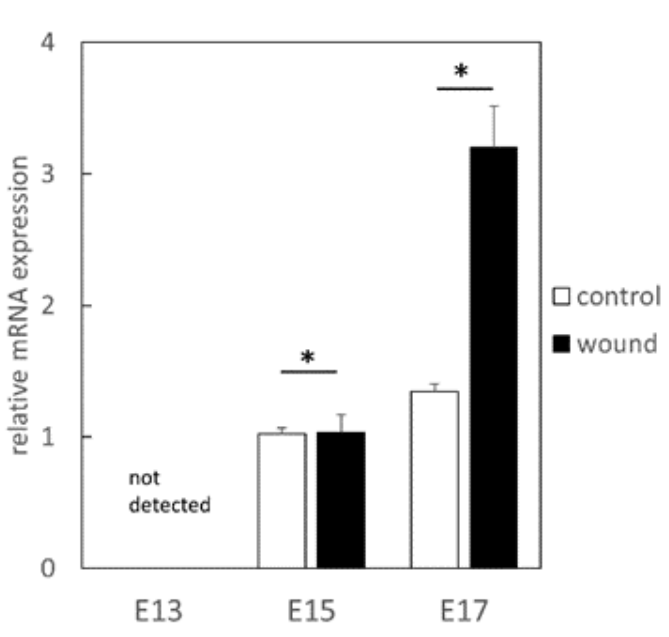
Figure 1. Lhx2 expression in the wound during embryonic mouse development. ( A ) Immunostaining. Yellow arrows: expression sites, Bar = 100 µ m. ( a – c , e , g , i ): low magnification images of the wound; ( d , f , h , j ): high magnification images of the skin appendages. ( B ) In situ hybridization. Expression is specific to the hair follicles of E15 and E17 and the dermis of the E17 wound. Bar = 100 µ m. ( a – c , e , g , i ): low magnification images of the wound; ( d , f , h , j ): high magnification images of the skin appendages. ( C ) Gene expression was significantly upregulated in the E17 wound compared to that in normal skin. * p < 0.05. Scale bar = 100 µ m.